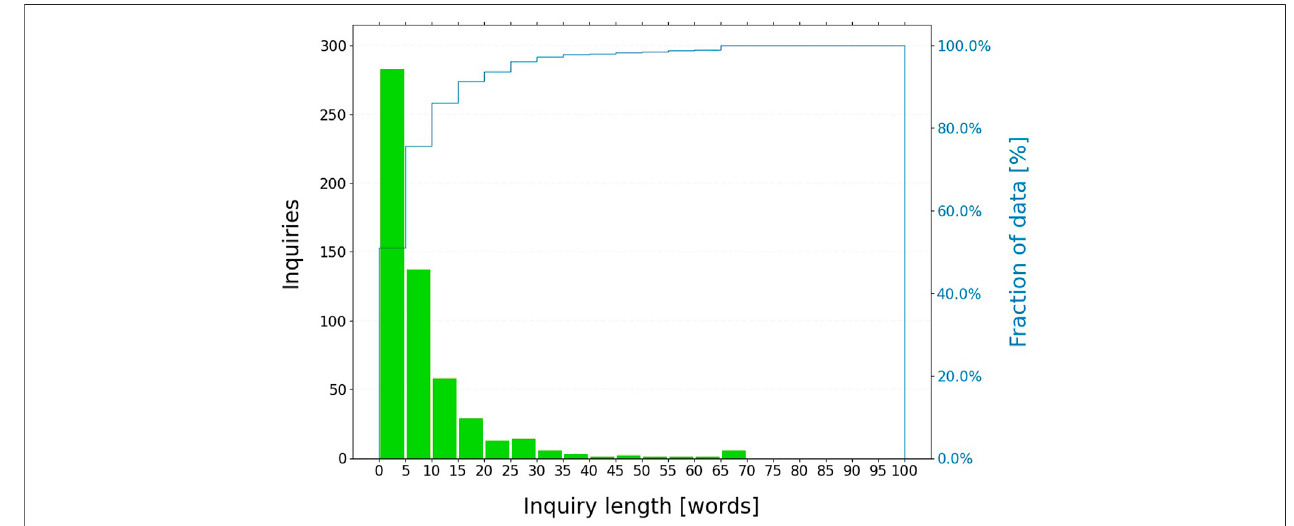
FIGURE 3 | Length distribution of medical inquiries on regorafenib. The dataset contains 3,880 medical inquiries; most of the inquiries ( ∼ 90%) contains less than fi fteen words after preprocessing.